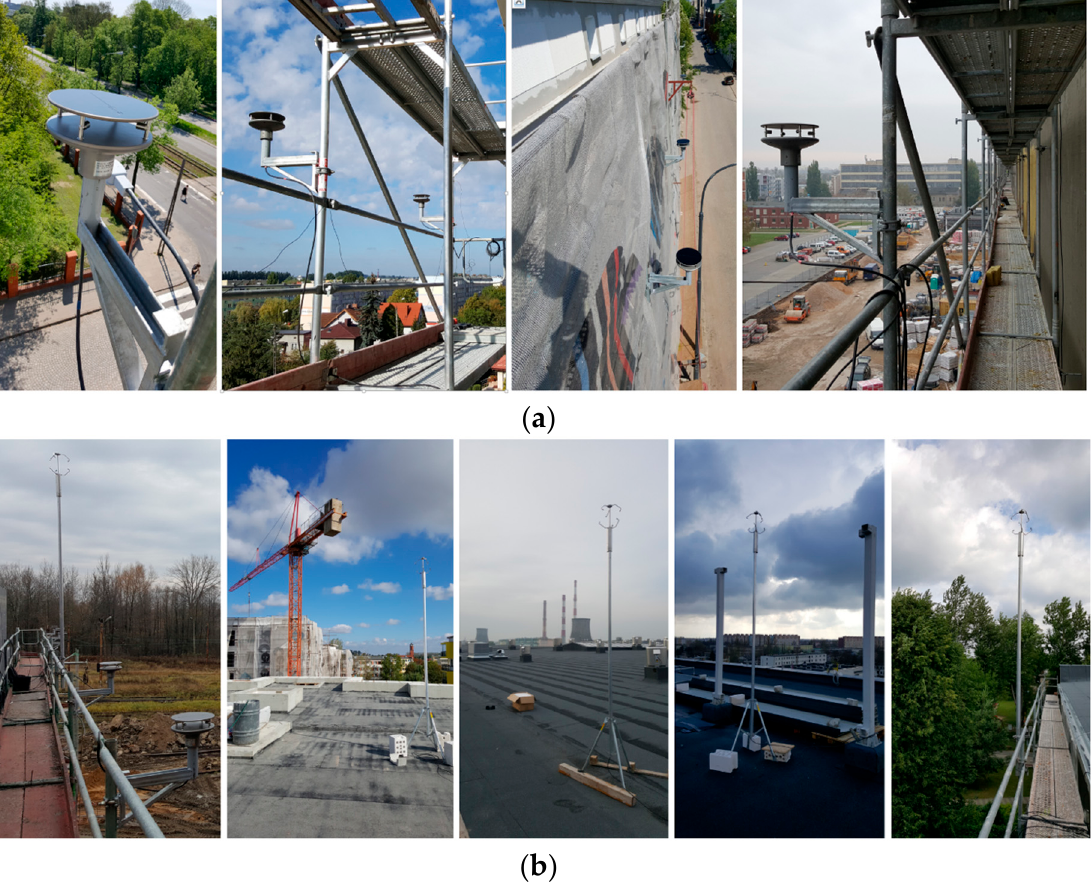
Figure 3. System field application: ( a ) 2D anemometers; ( b ) 3D anemometers.